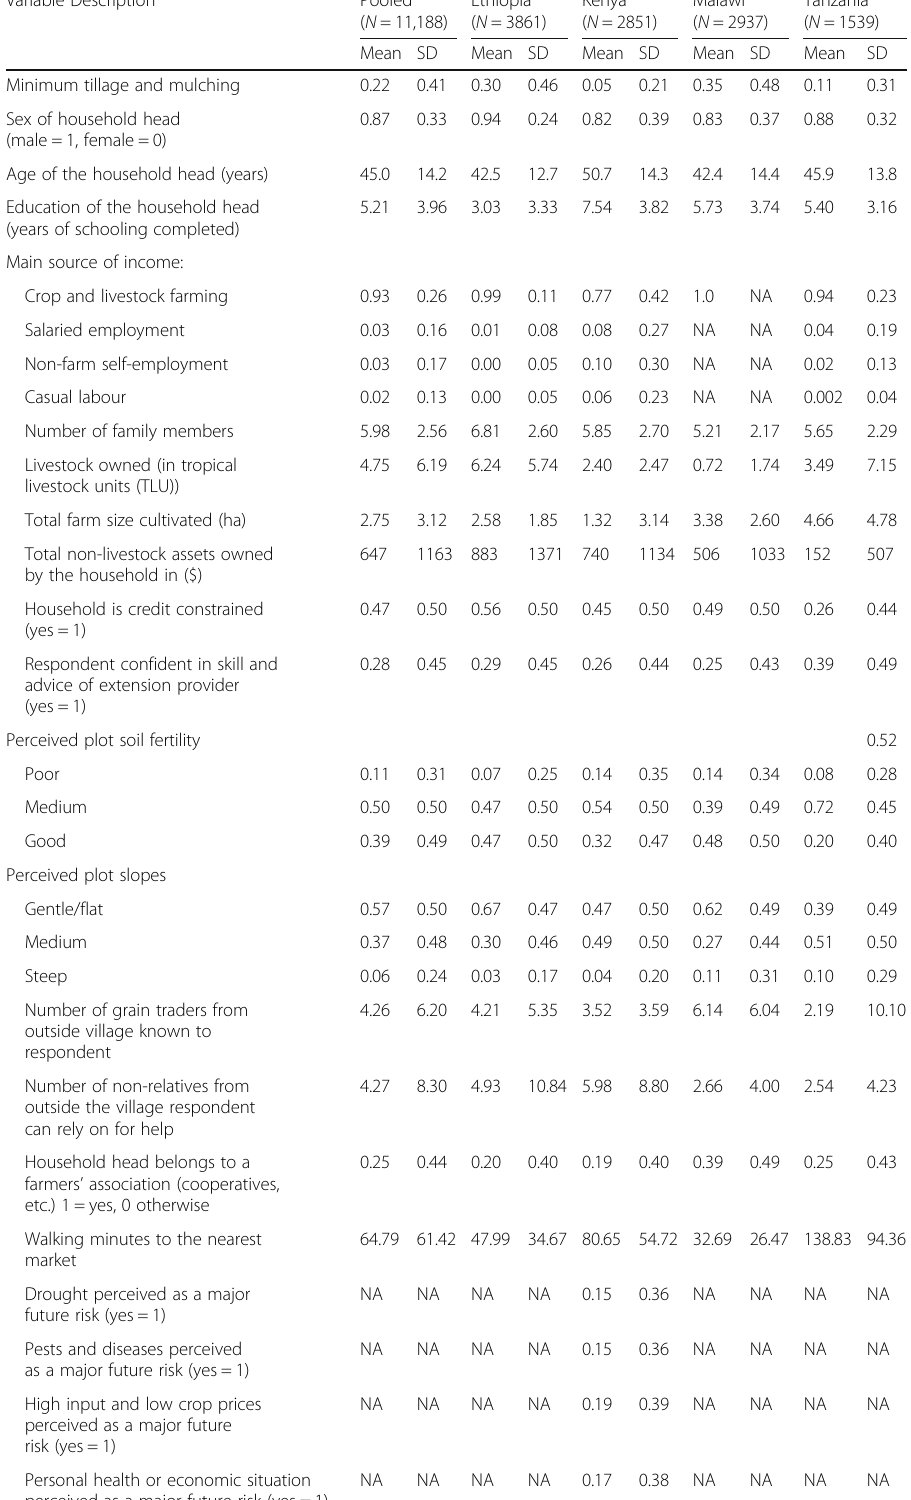
Table 2 Variable definitions and summary statistics Variable